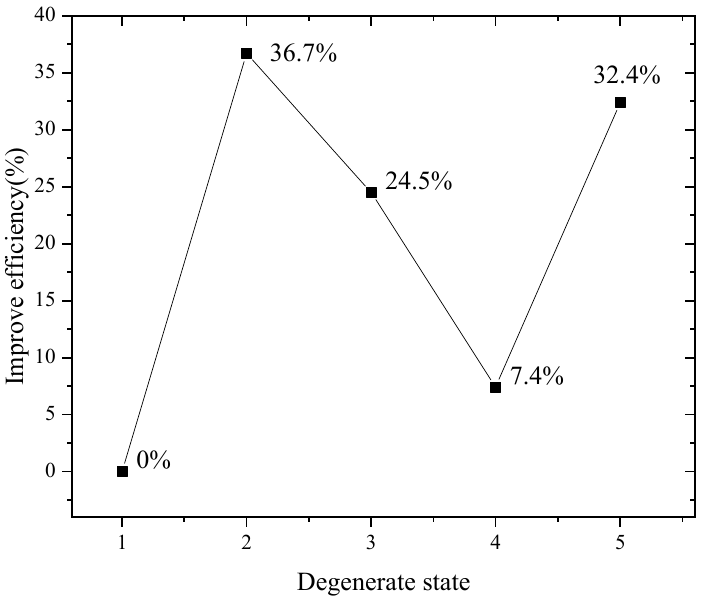
Figure 12. Improve efficiency by increasing the number of